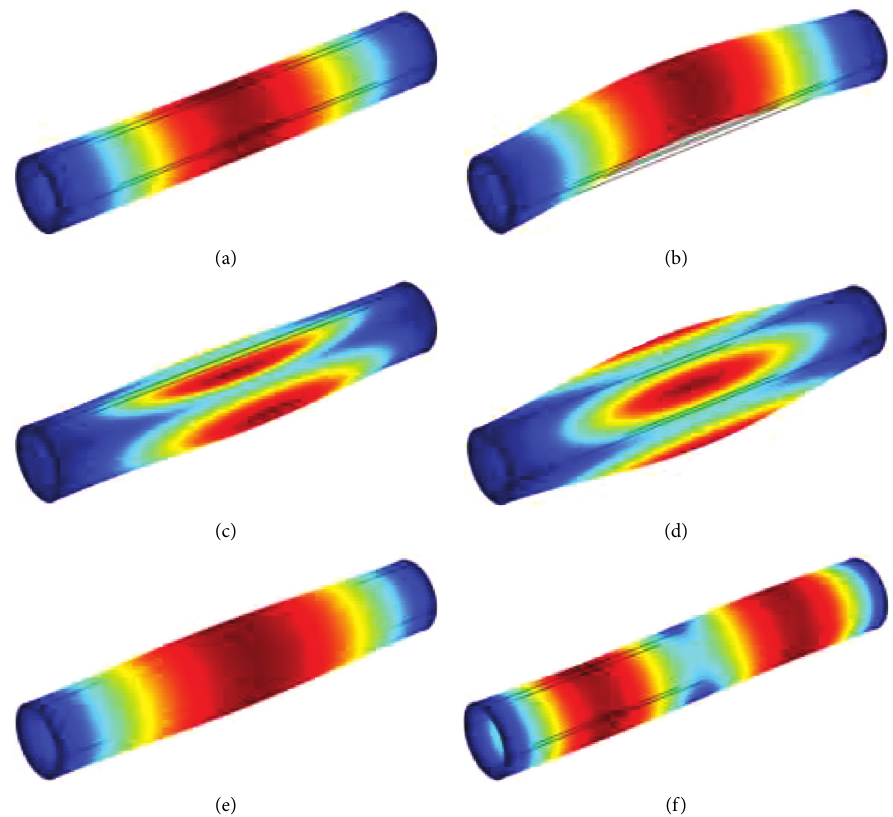
Figure 4: Fixed-fixed carbon nanotube fundamental frequency analysis for L/D ratio 7.2. (a) Fundamental frequencies F1, (b) F2, (c) F3, (d) F4, (e) F5, and (f) F6.